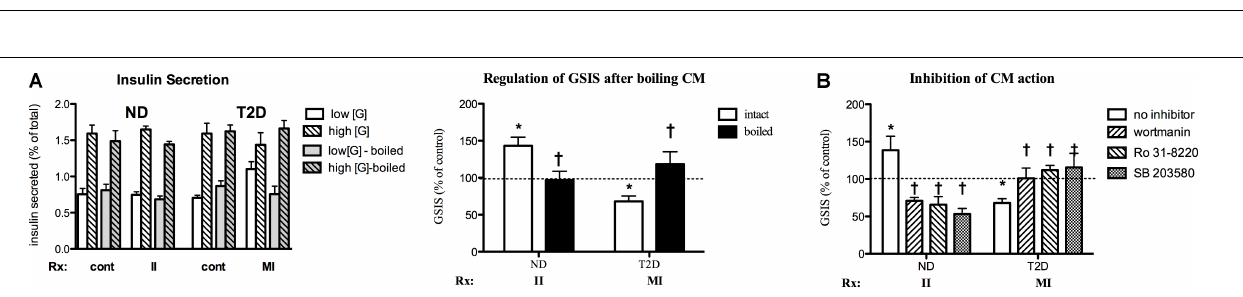
Frontiers in Physiology |